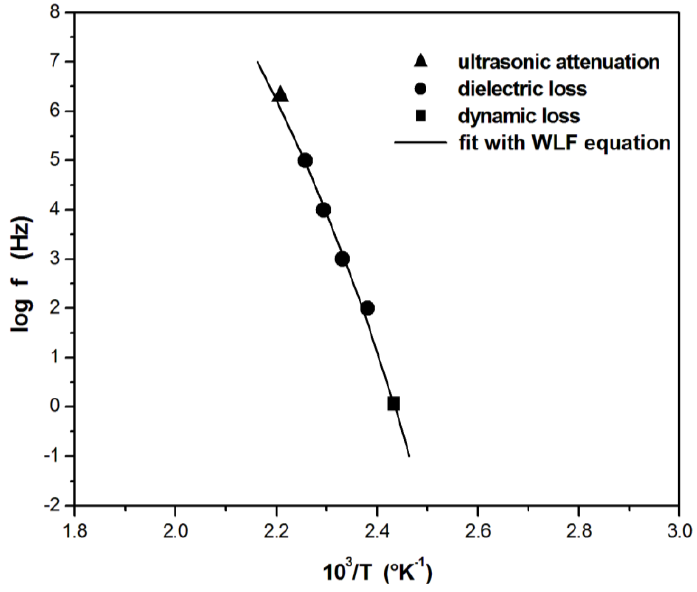
Figure 9. Frequency dependence of the relaxation peaks of unsaturated polyester networks as measured by DMA (square), DEA (circles) and UDMA (triangle). The data are fitted by the WLF equation (continuous line). Reprinted with permission from [8]. Copyright 2005 Wiley Periodicals,